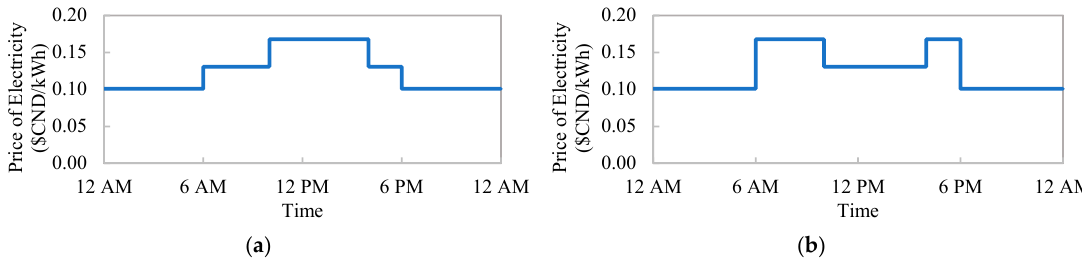
Figure 6 . Time-of-use pricing scheme for electricity costs in Ontario, Canada for the following: ( a ) summer weekdays (1 May–31 October) and ( b ) winter weekdays (1 November–30 April).